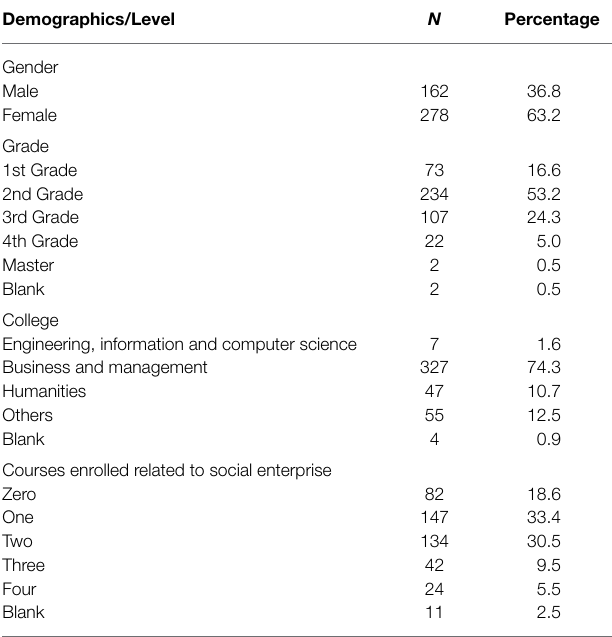
TABLE 1 | Profiles of participants ( N = 440).